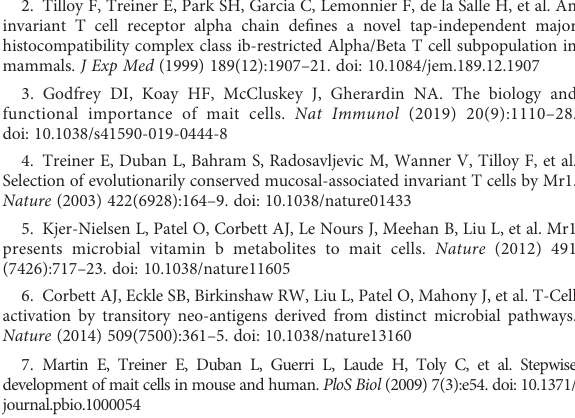
SUPPLEMENTARY FIGURE 1 Age distribution and MAIT cell levels in HIV-1-uninfected cohort. (A) Age distribution strati fi ed by sex in HC carrying the IL7RA haplotype 2 vs non- haplotype 2. (B) MAIT cell levels in female and male participants of the healthy cohorts strati fi ed by IL7RA haplotype. (B) Box and whisker plots show all data points, median, and the interquartile range. Statistical signi fi cance was determined using Mann-Whitney ’ s test. ns, not signi fi cant. SUPPLEMENTARY FIGURE 2 Soluble IL-7R a does not inhibit IL-2-mediated MAIT cell proliferation. (A – G) MR1-5-OP-RU tetramer + V a 7.2 + MAIT cell (A) proliferation as determined by Ki-67 expression levels on Ki-67 + MAIT cells (B ; left panel , C) , absolute MAIT cell numbers (D) , and proliferation (E) and expansion (F) indices calculated using CTV-dilution (B ; right panel ) following 5-days treatment of PBMC with 5-OP-RU, 5-OP-RU+IL-2, or 5-OP-RU+IL-2+sIL-7R a (sIL-7R a /IL-2 molar ratio 1:1) (N=5). (G) Dose- dependent effect of sIL-7R a treatment on MAIT cells proliferation and expansion indices following 5-days treatment with IL-2 and 5-OP-RU (N=5). Expression levels for (G) were normalised to nil sIL-7R a controls to minimise inherent donor-to-donor variability, with statistical tests were performed on raw data. Box and whisker plots show all data points, median, and the interquartile range, whereas data presented as line graphs with error bars represent the mean and standard error. Statistical signi fi cance was determined using the Friedman test followed by Dunn ’ s post-hoc test (C, D) , or repeated measure one-way ANOVA with Tukey ’ s post-hoc test (E, F, G) . ** p<0.01, * p<0.05, ns, not signi fi